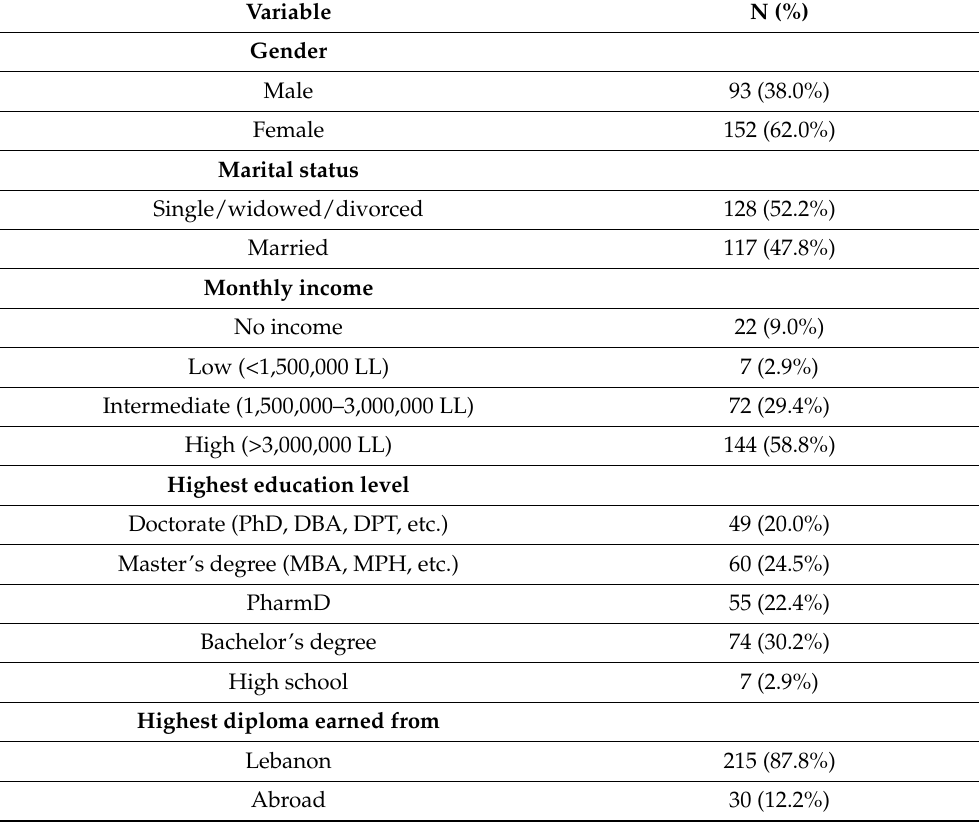
Table 1. Sociodemographic and work characteristics of the participants (N =